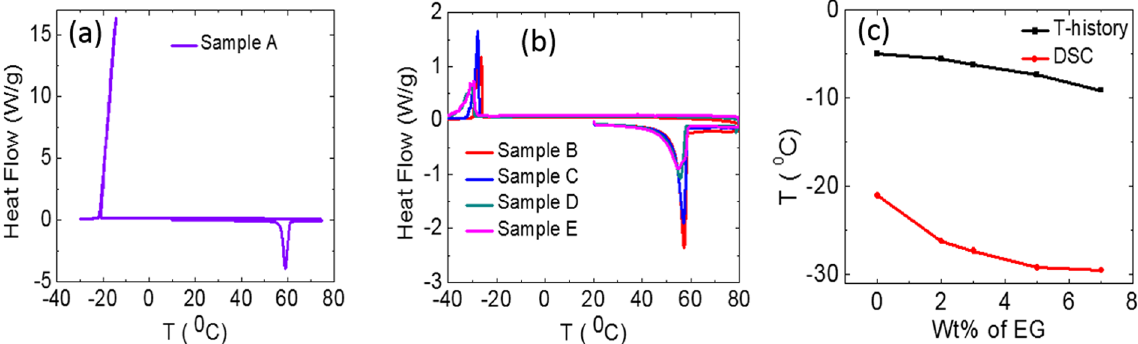
Figure 6. Differential scanning calorimetric (DSC) thermograph for sample A ( a ); samples B, C, D, and E ( b ) and supercooling temperature for these samples, measured using DSC and T-history methods ( c